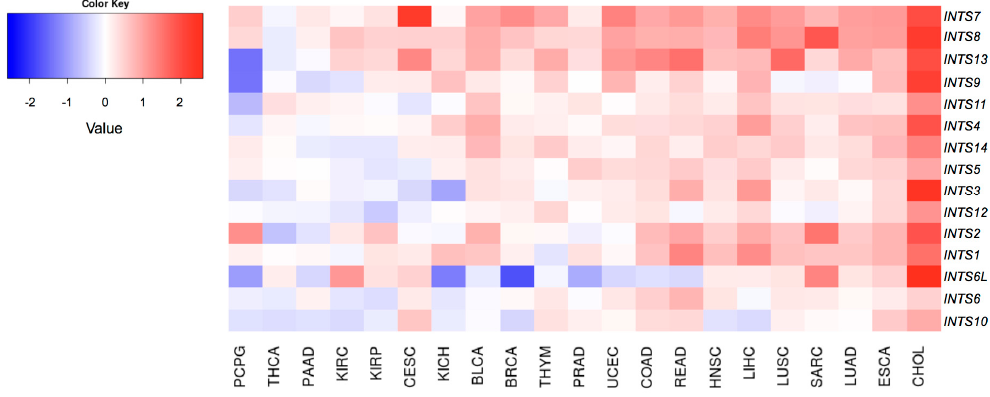
Figure 4. The heatmap shows the expression profiles of INT genes across analyzed cancer types.